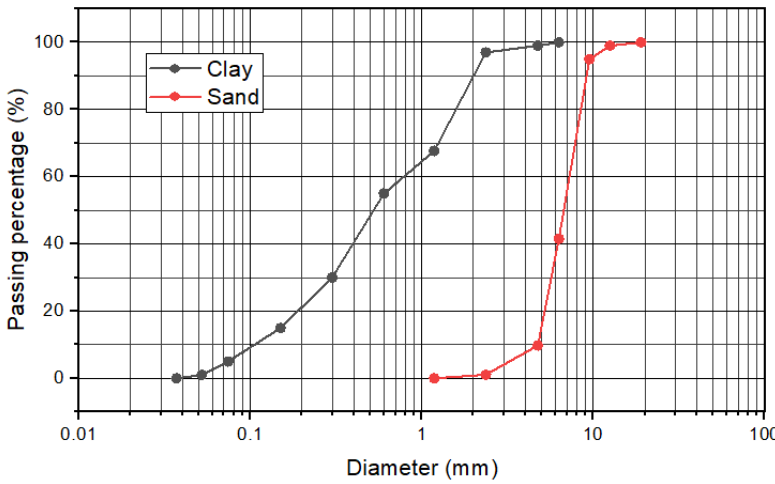
Figure 7. Granulometry of the materials used in the production of adobe